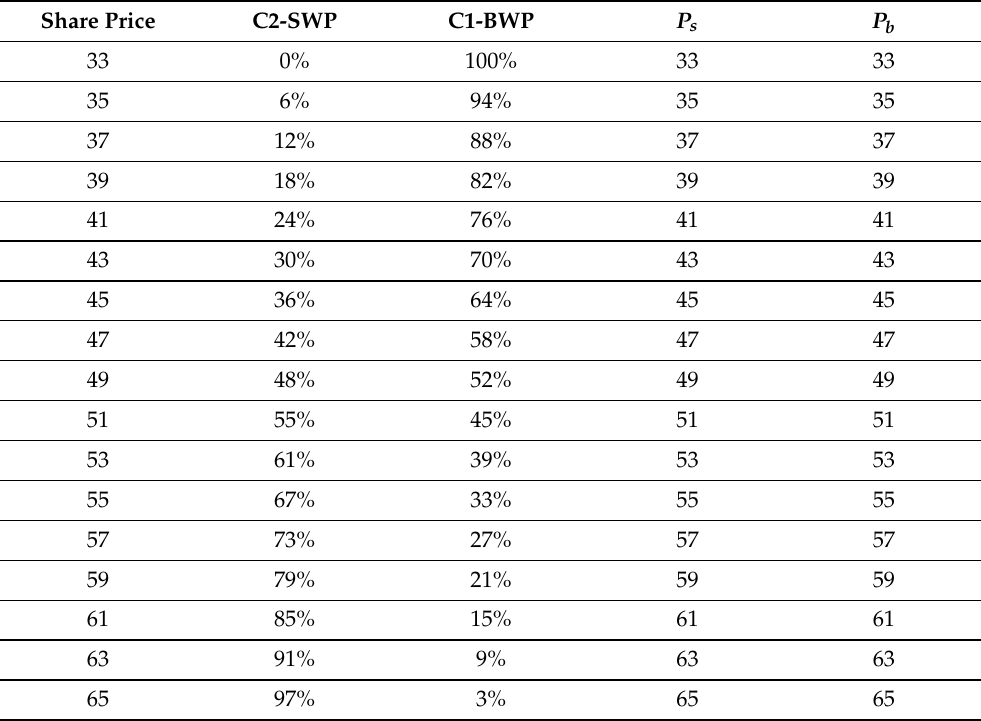
Table 2. A toy example illustrating the calculation of wining percentages produced using the proposed